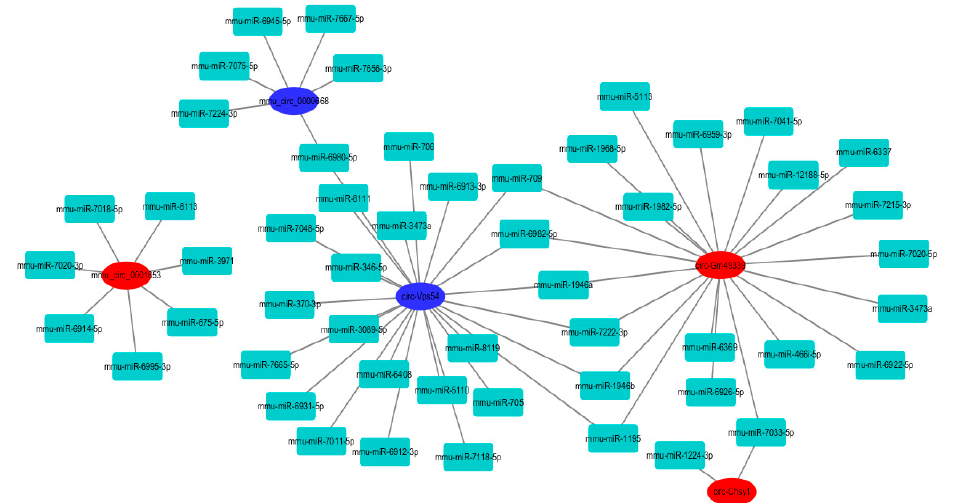
Figure 8. Construction of circular RNAs–miRNA network. Blue indicates down-regulated circular RNAs, red indicates up-regulated circular RNAs, linked to them are their targeted miRNAs.